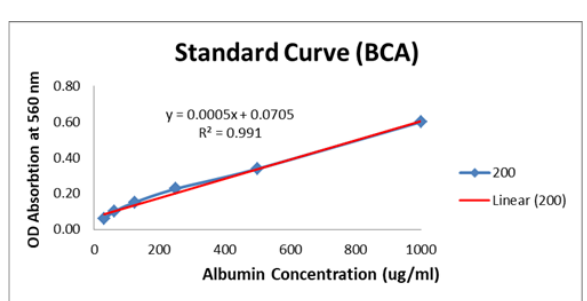
Figure 3. The standard curve for determining the concentration of protein by BCA